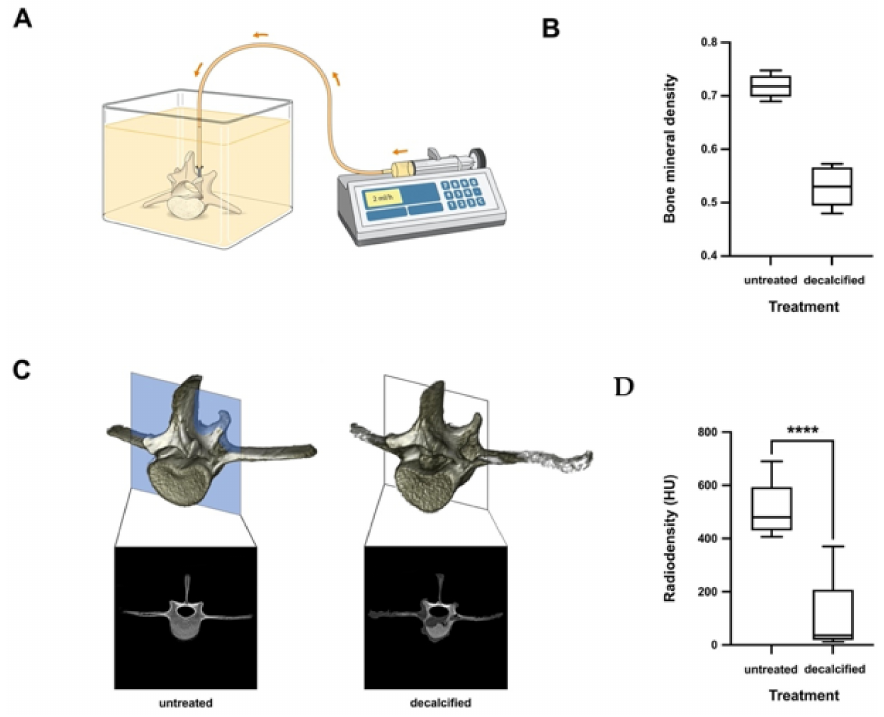
Figure 4. ( A ) Ovine osteoporosis model in vitro. ( B ) The BMD of the vertebrae of adolescent sheep was 0.72 ± 0.02 g/cm 2 . ( C , D ) The BMD at the center of the mid-sagittal cross-section measured using CT was 511.8 ± 90.6 HU. BMD in the vertebrae of adolescent sheep treated with a decalcifying solution was 0.53 ± 0.04 g/cm 2 . The BMD at the center of the mid-sagittal cross-section measured using CT was 101.3 ± 124.4 HU. The BMD was decreased by 28.75% ± 2.6%. **** p < 0.0005.